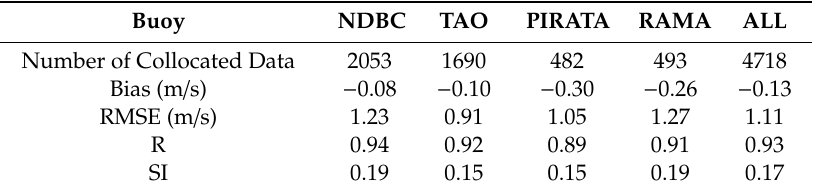
Table 1. WS errors between Sentinel-3A and moored buoys.